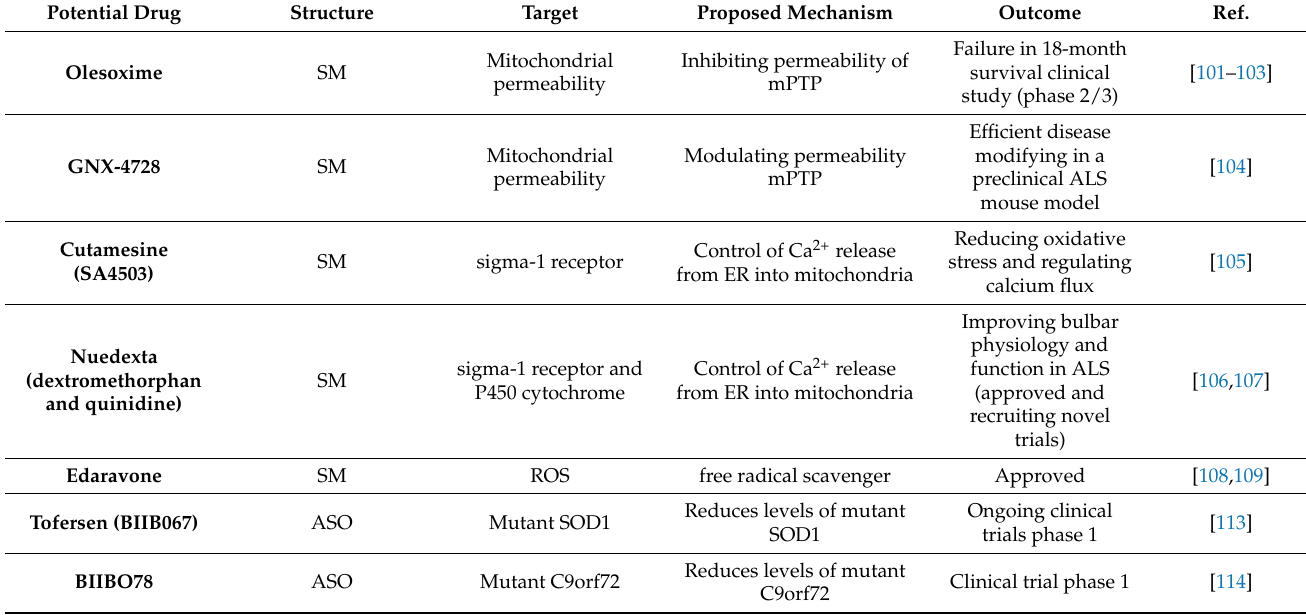
Table 2. Studies of potential drugs targeting mitochondrial